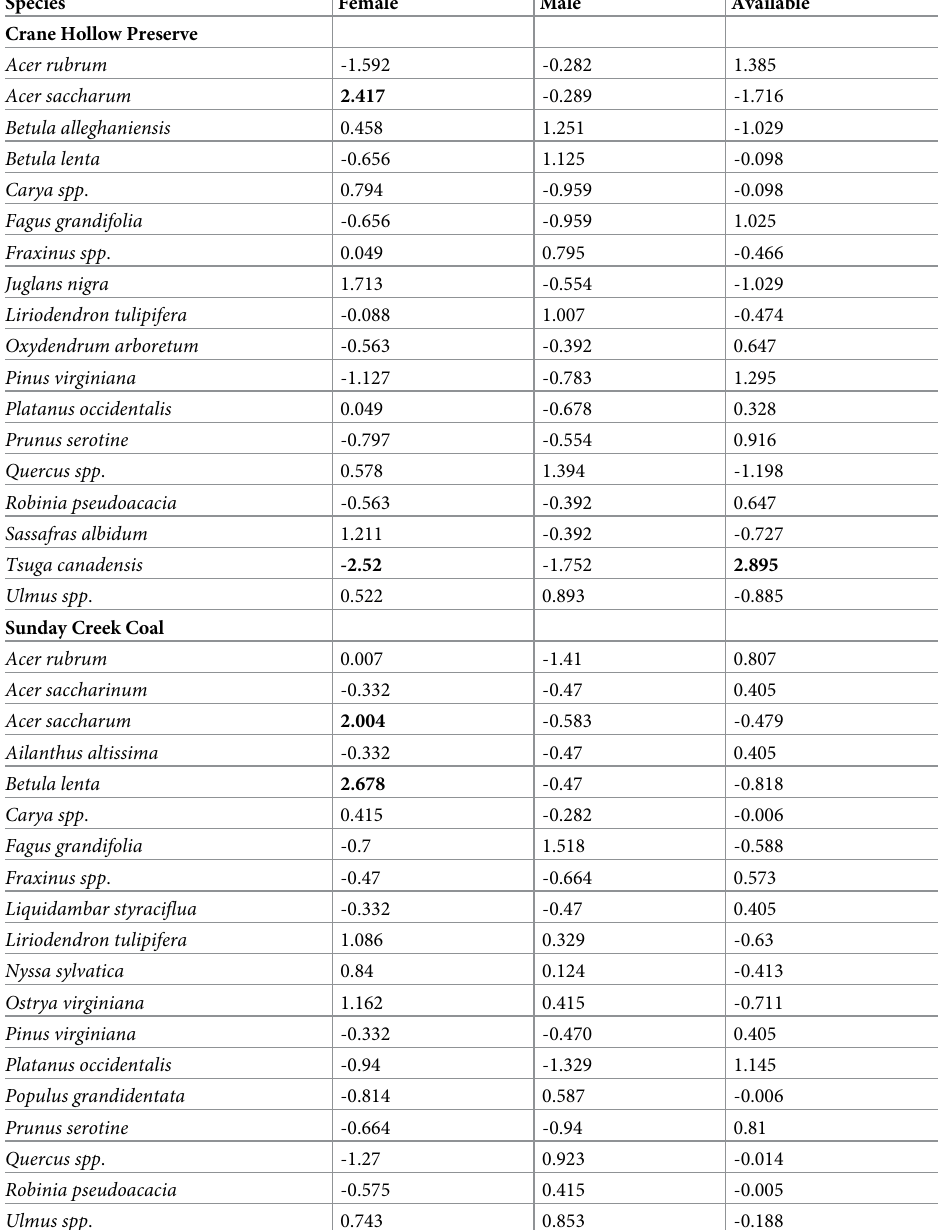
Table 1. Standardized Pearson’s residuals comparing roost tree species used by male, female, and available trees on the landscape in two study areas in Ohio from 2016–2019. Species Female Male